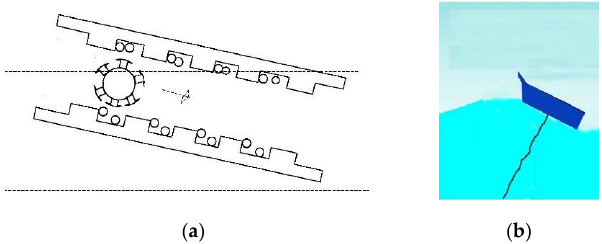
Figure 3. Step 1: The sea wave is approaching the face of the converter: ( a ) cross-section view; ( b ) graphical representation.